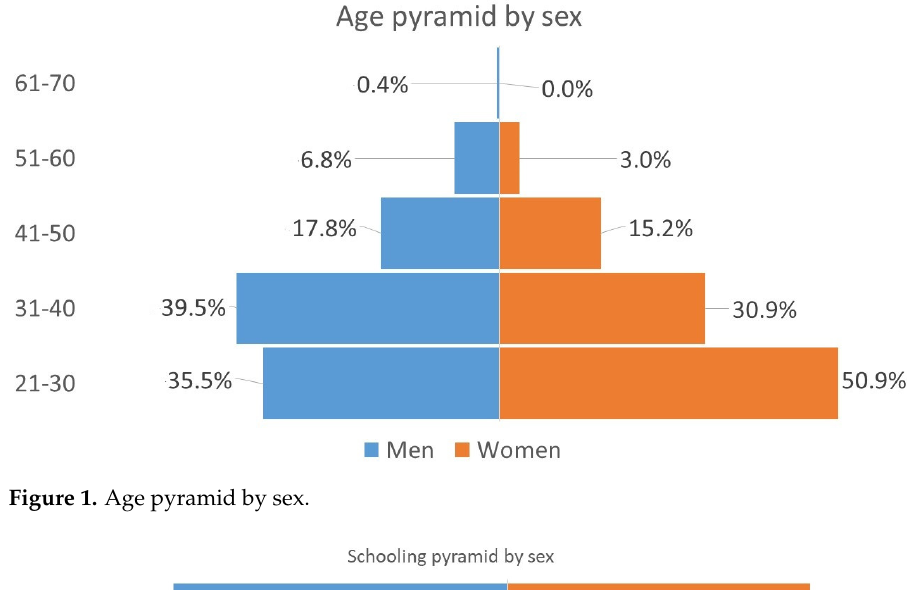
Figure 1. Age pyramid by sex.